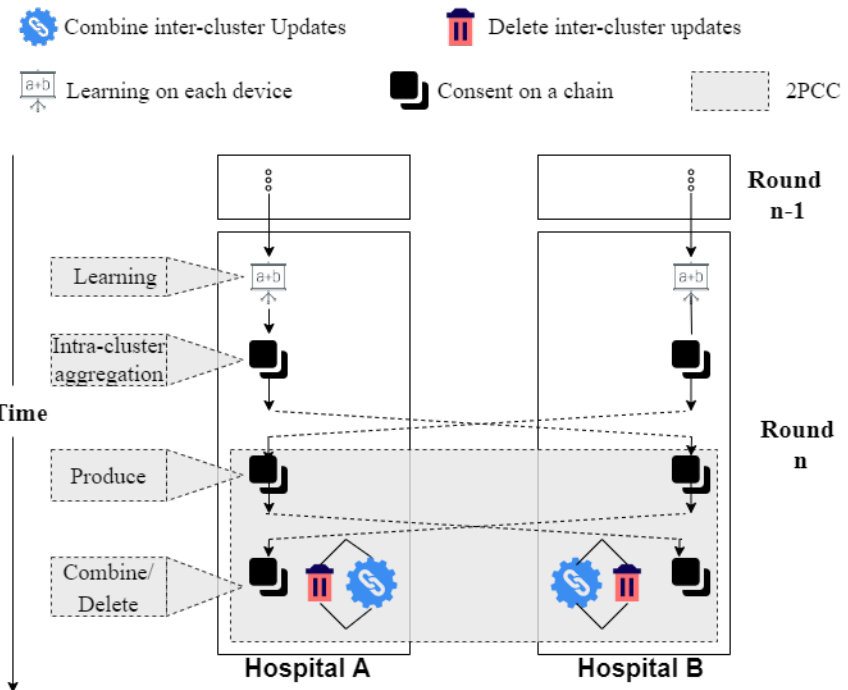
Figure 8. The HstCon algorithm’s process flow